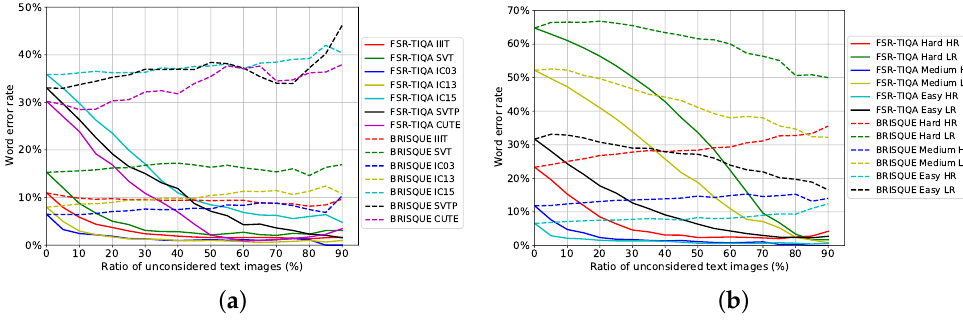
Figure 7. Text recognition performance on the predicted text image quality score. The curves show the effectiveness of rejecting low-quality text images in datasets. ( a ) shows the result for benchmarks. ( b ) shows the same for three subsets in Textzoom.